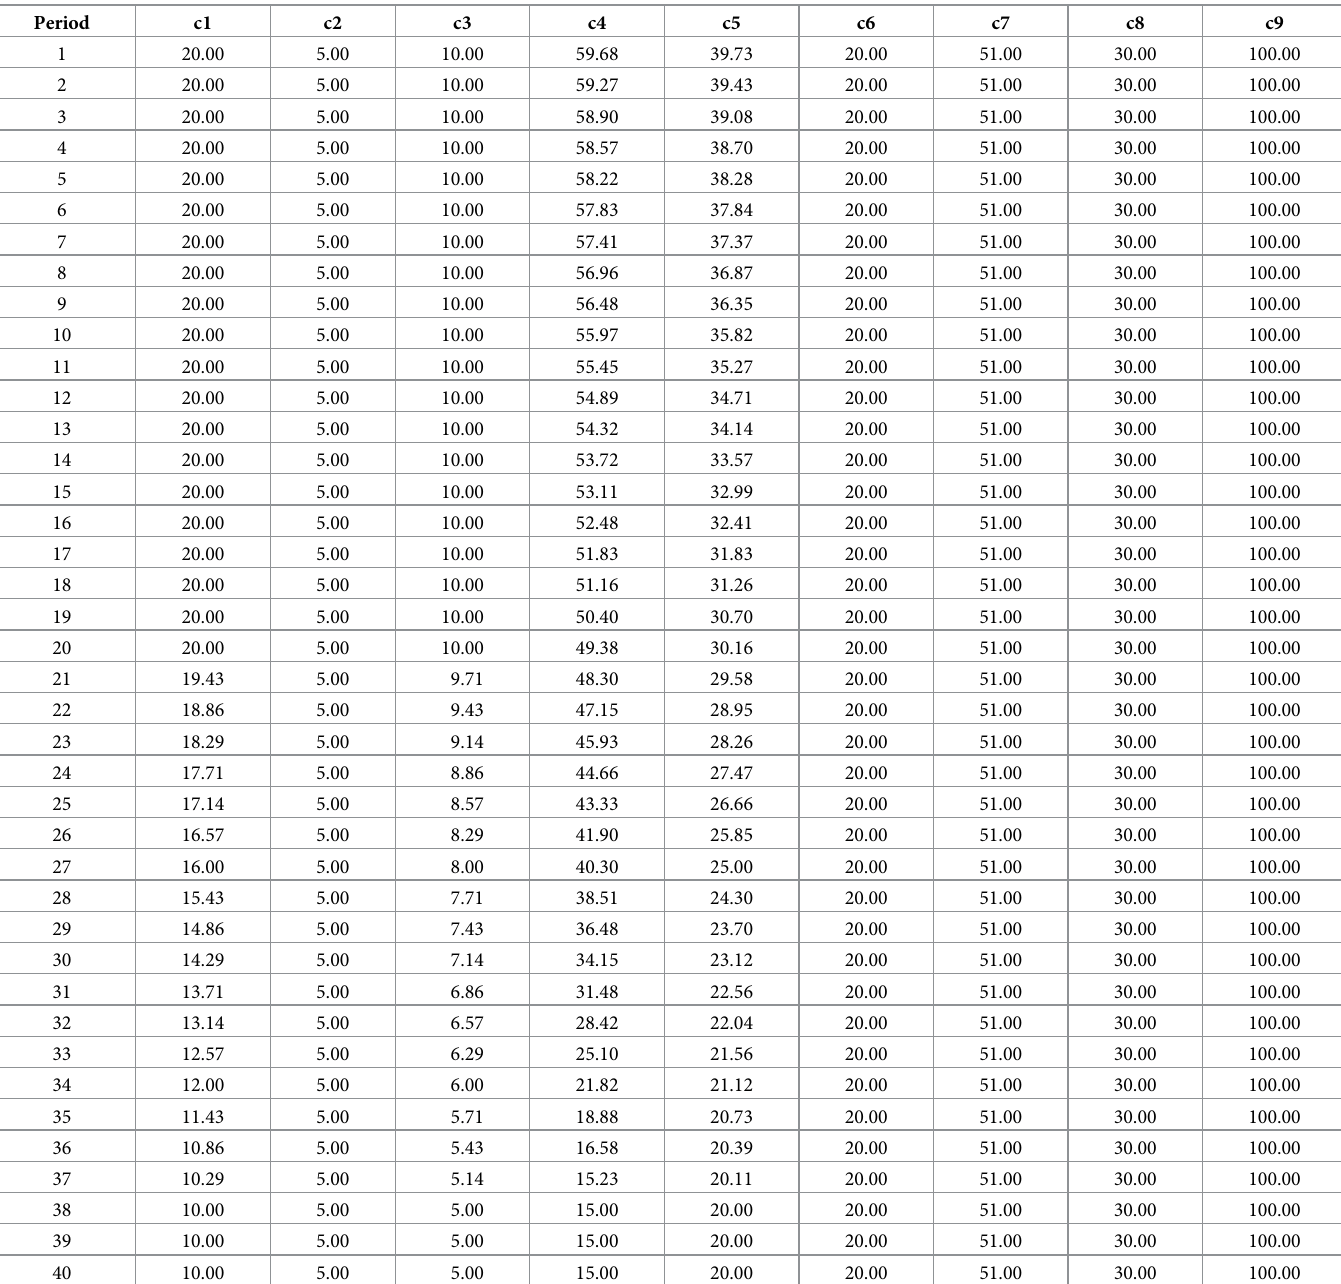
Table 2. Investment limits considered for each